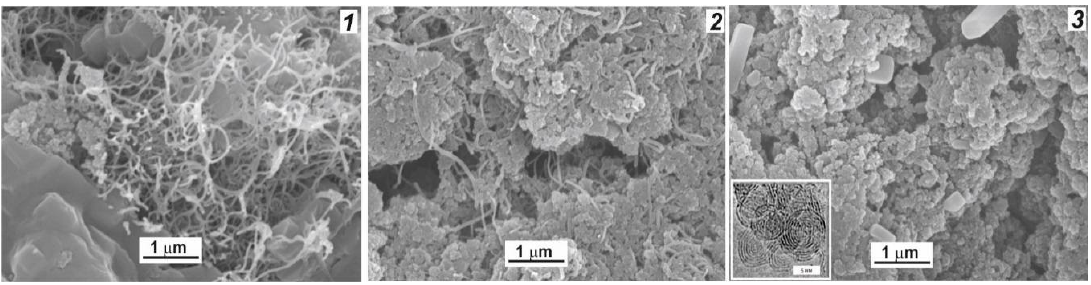
Figure 7. SEM images of cleavages of the biocatalysts prepared by immuring r E. сoli /lip lysates inside nanocarbons-in-silica composites: 1— CNT1s, 2 —CNT2s, 3 —CNSs. Smooth areas correspond to